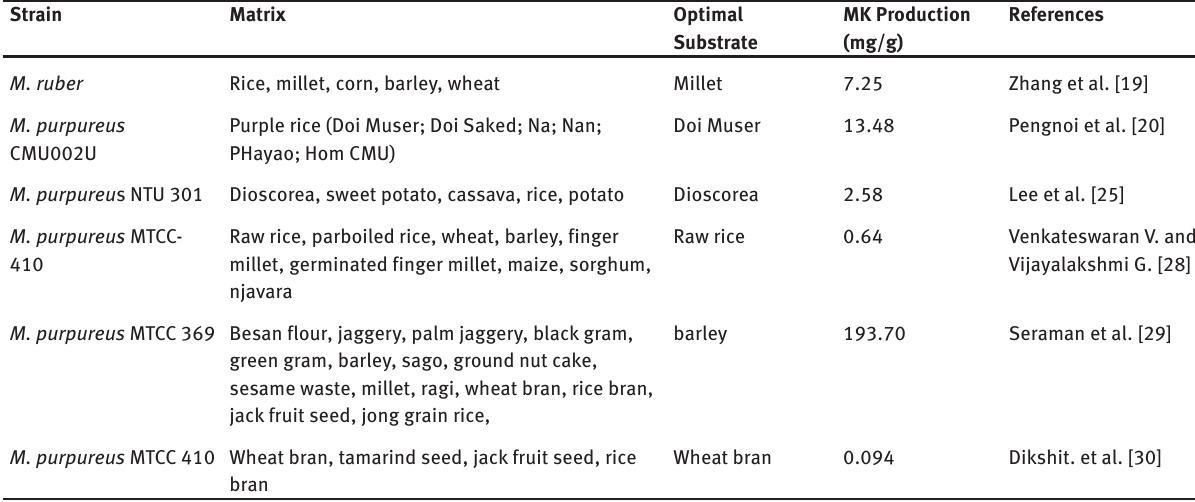
Table 2: Comparison of MK Yield by Monascus Fermentation Using Different Matrixes. Strain